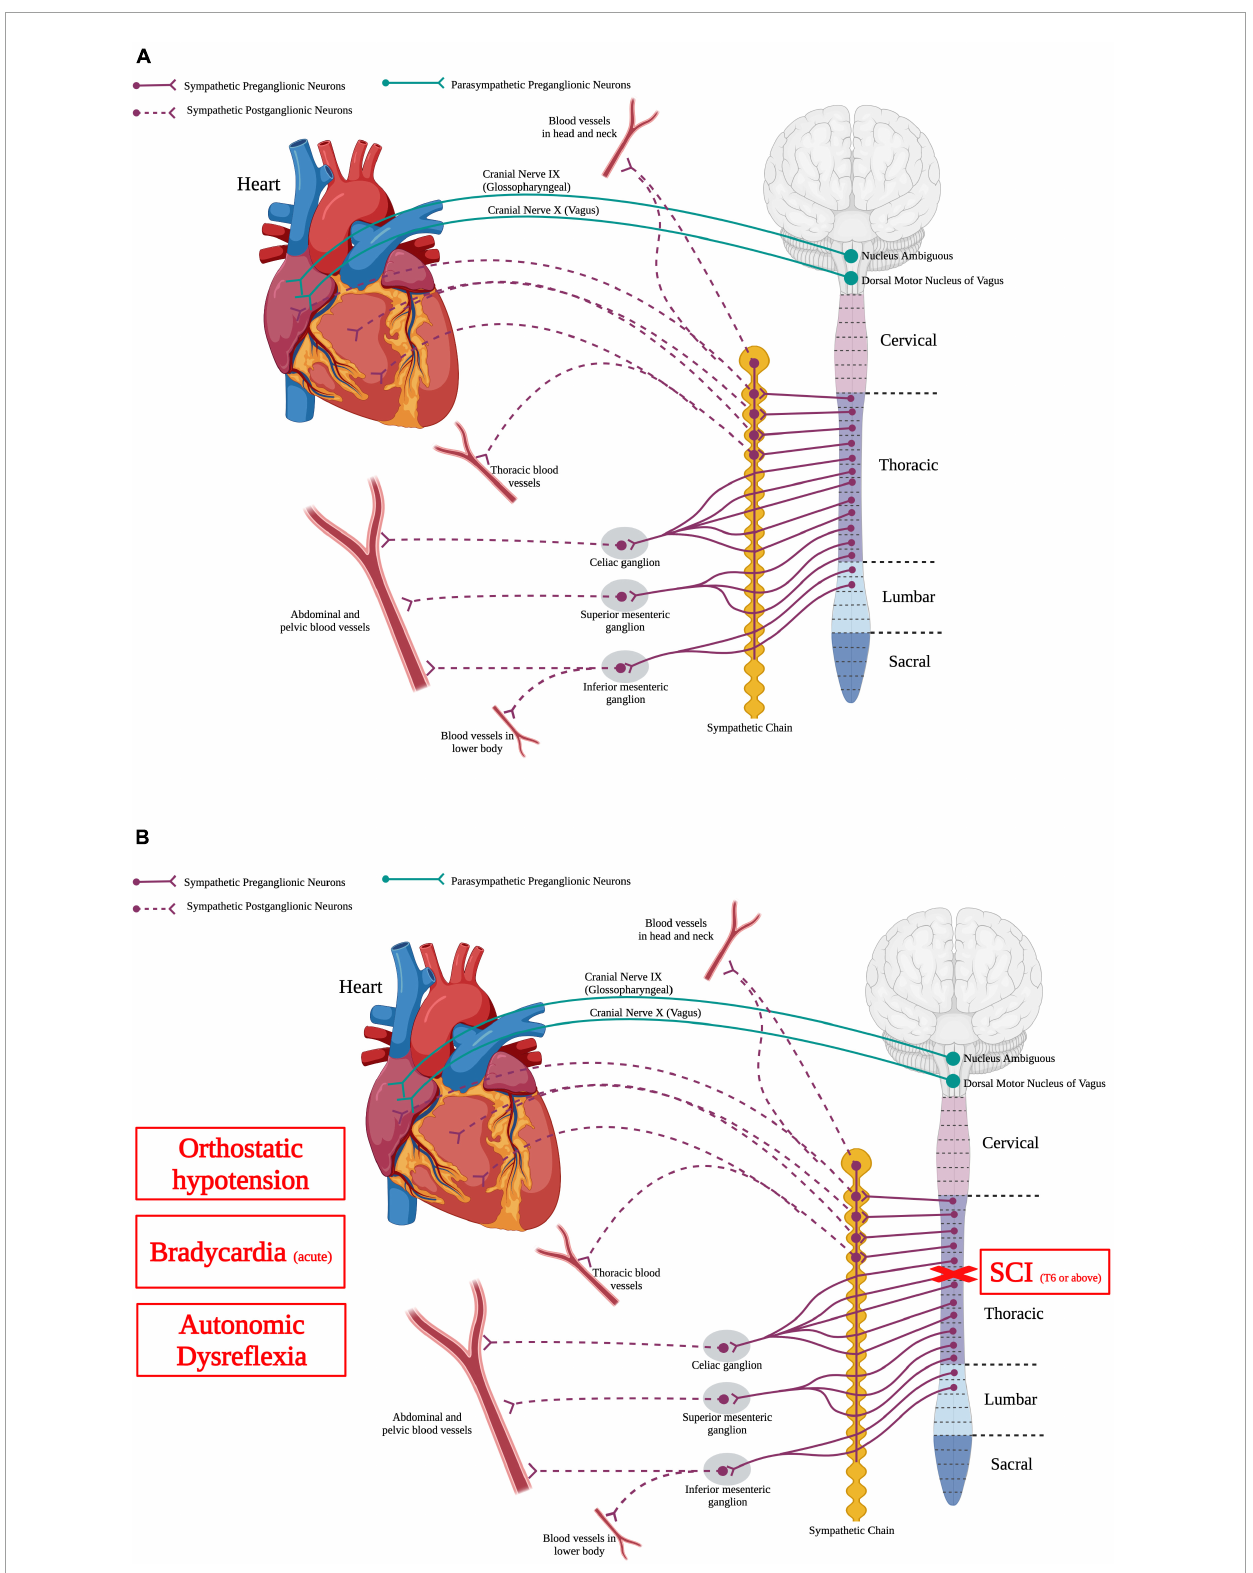
FIGURE3 Autonomic control of the cardiovascular system and how SCI impacts the cardiovascular system. (A) The heart is innervated by sympathetic postganglionic neurons that receive input from sympathetic preganglionic neurons in thoracic segments 1–4. Parasympathetic regulation of the heart originates from the nucleus ambiguous and dorsal motor nucleus of vagus within the brainstem. Autonomic control over the vasculature is solely from the sympathetic nervous system. (B) SCI at or above T6 results in deranged sympathetic activity that results in orthostatic hypotension, bradycardia in the acute phase, and autonomic dysreflexia. (Created using